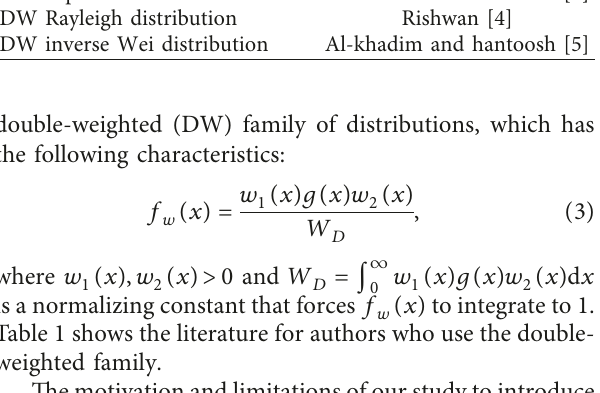
Table 1: Some literature of double-weighted distributions.